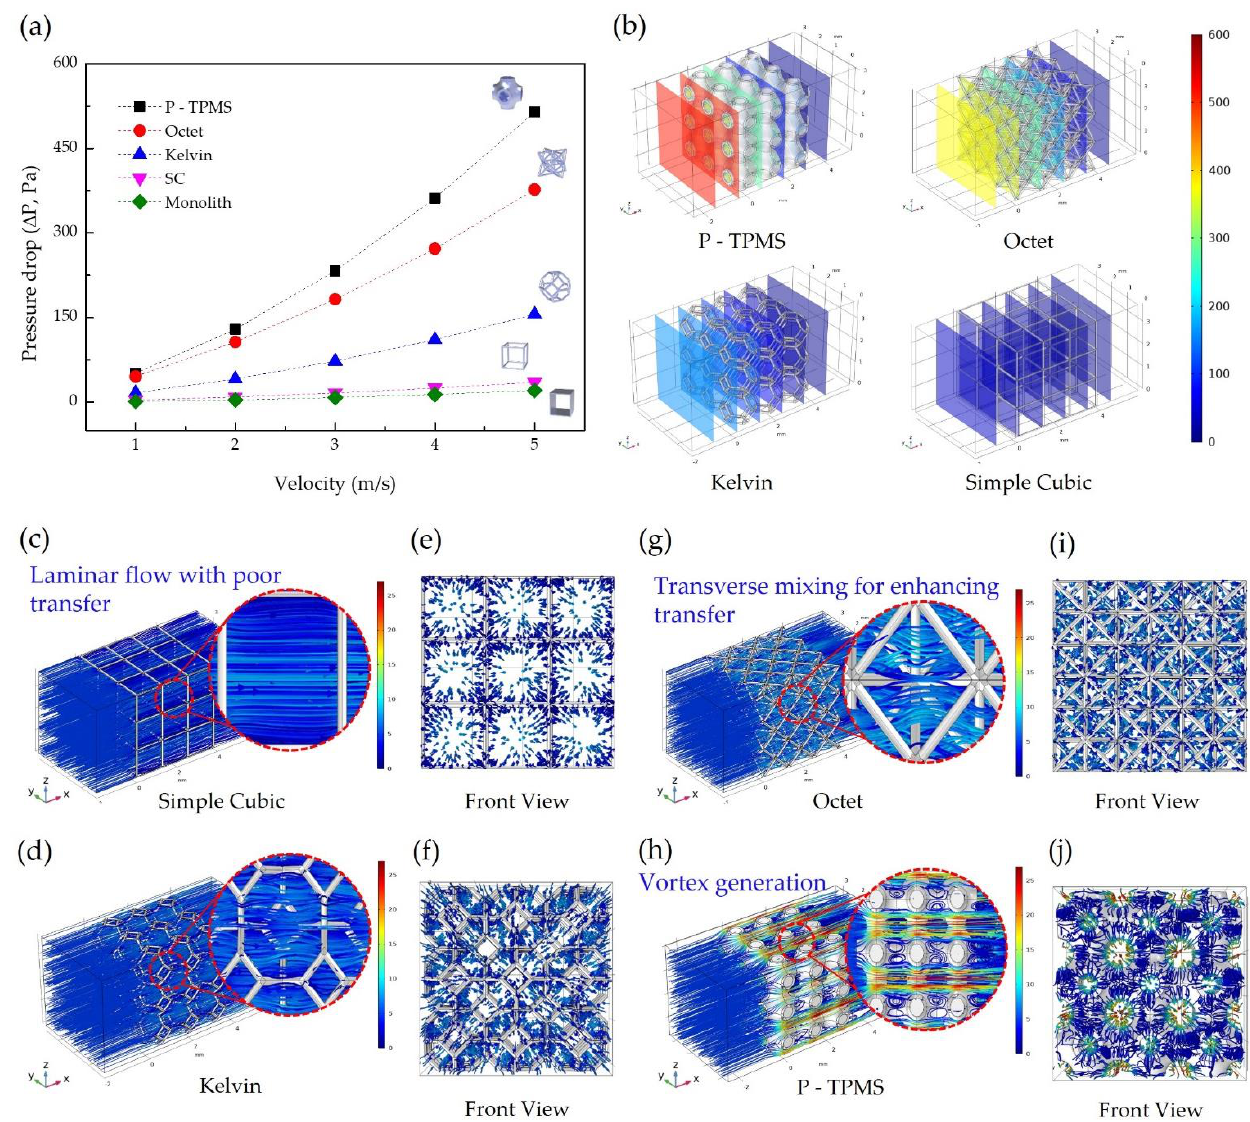
Figure 4. Characteristics of the fluid flow through the 3D microstructures. ( a ) Pressure drop as a function of the fluid velocity; ( b ) pressure drop as a function of the axial position; ( c , d , g , h ) velocity distributions for the different 3D microstructures; ( e , f , i , j ) front view of fluid flow distributions.